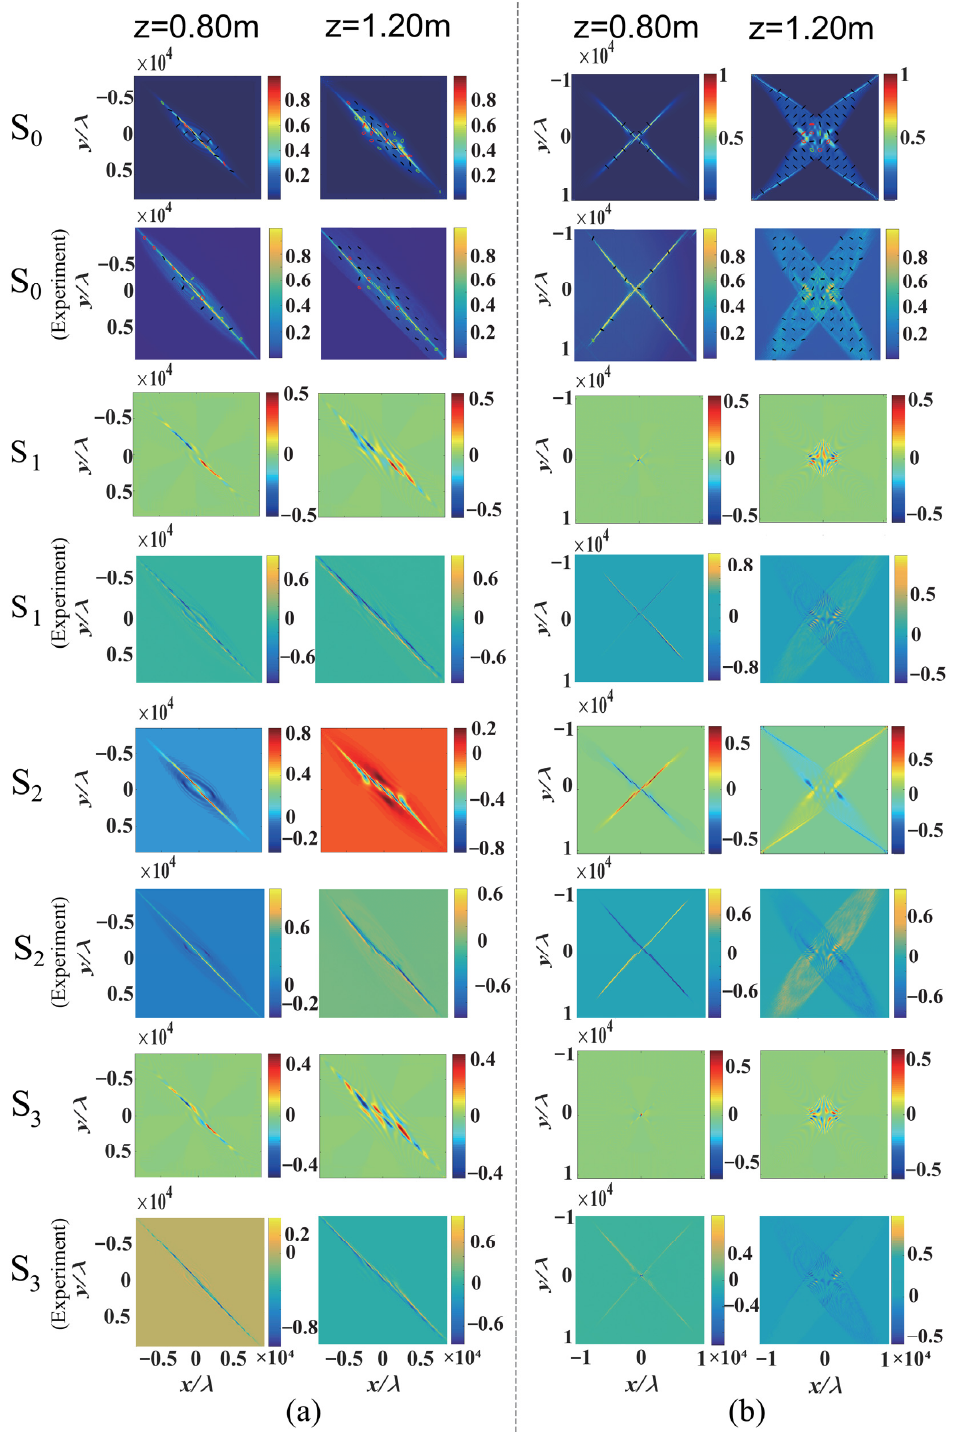
Figure 4. Stokes parameters of isotropic and anisotropic twisted vector beams with hybrid SoP in different propagation distances: ( a ) u 1 = 10 mm − 2 , u 2 = 15 mm − 2 , m 1 = 4, m 2 = − 1, σ x = σ y =5 mm; ( b ) u 1 = 15 mm − 2 , u 2 = − 15 mm − 2 , m 1 = 3, m 2 = − 2, σ x = 2 σ y = 4 mm. The corresponding experimental results of S 0 are shown in the second − row plots of each case.